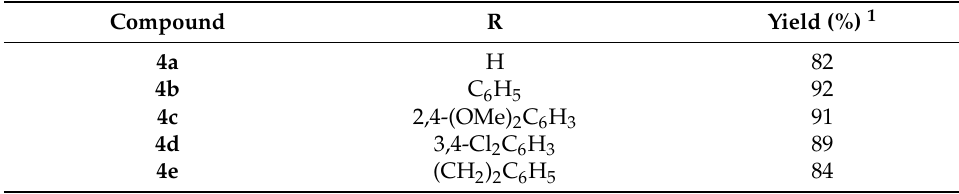
Table 2. Pyrano[4”,3”:4 (cid:48) ,5 (cid:48) ]pyrido[3 (cid:48) ,2 (cid:48) :4,5]thieno[3,2- d ]pyrimidin-8-ones 4